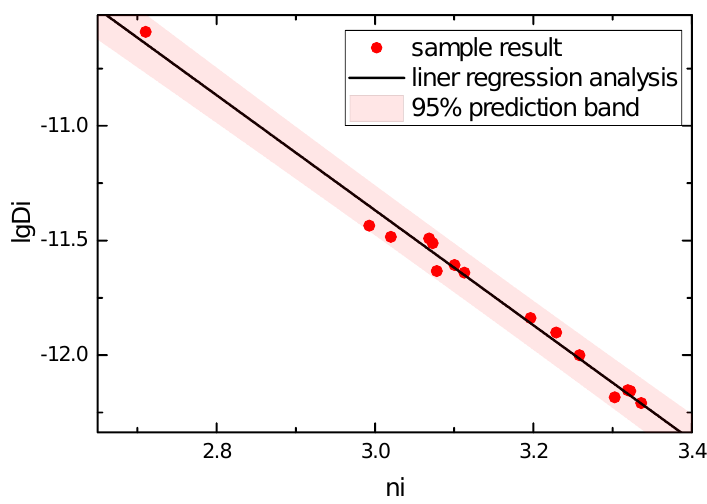
Figure 13. log D i and n i linear regression analysis.